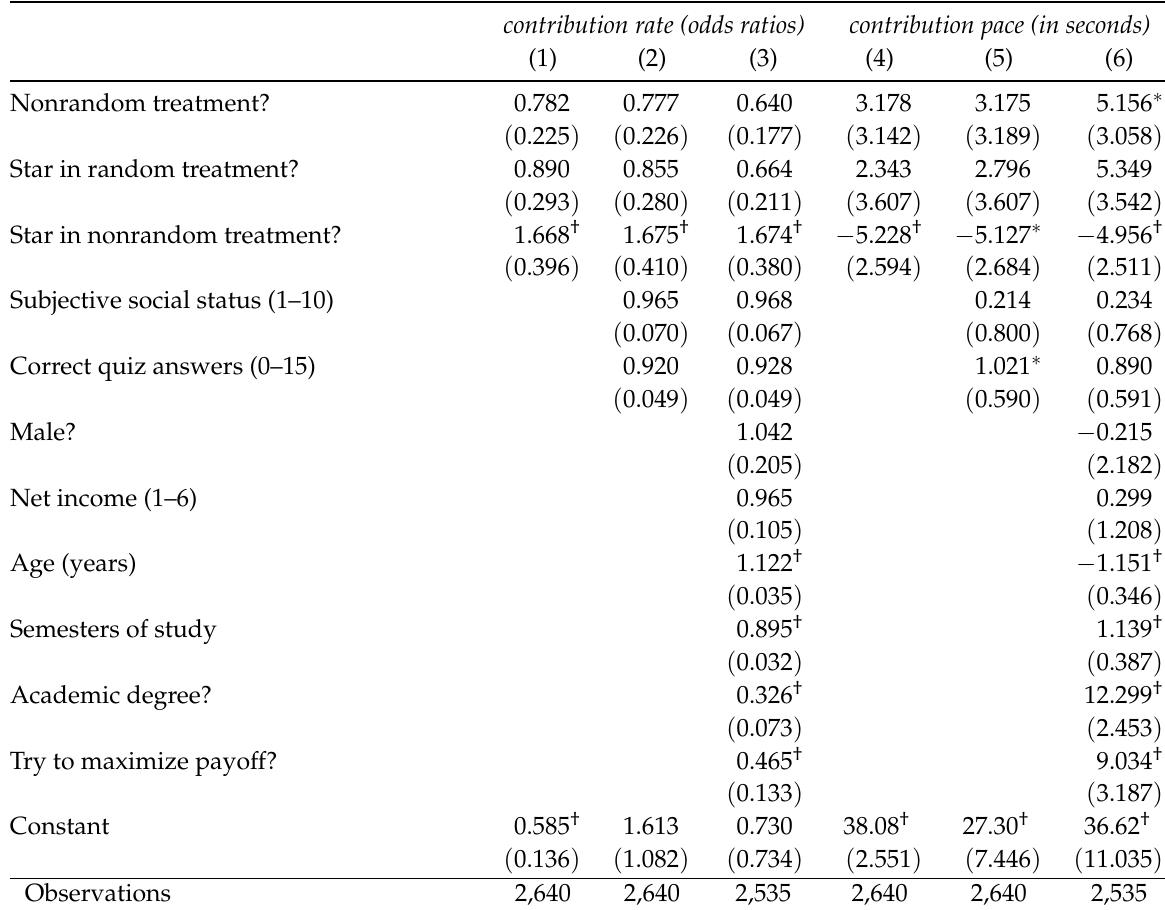
Table 1: Random effects logit (for contribution probability) and random effects linear (for contribution pace)